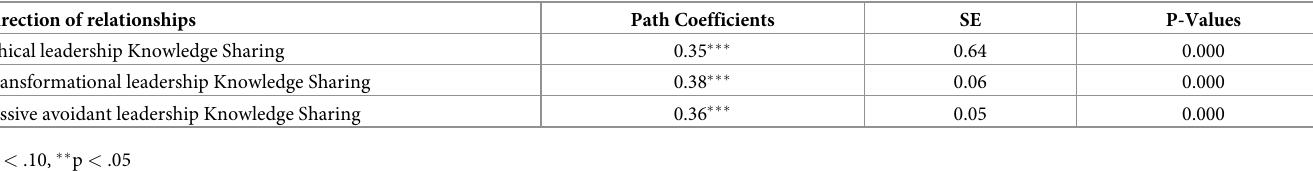
Table 3. Regression analysis.